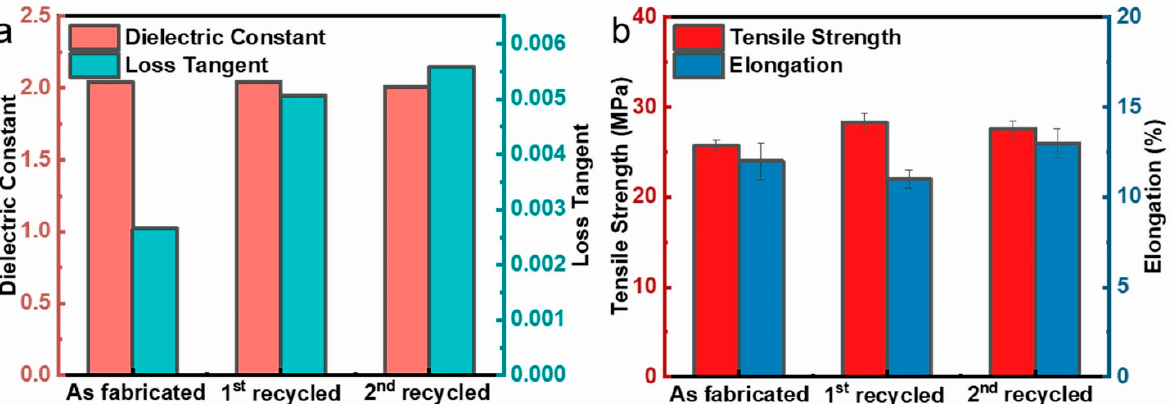
Figure 6. Recycle of porous sPI films: ( a ) dielectric constant and loss tangent at 10 5 Hz; ( b ) tensile strength and elongation at break.